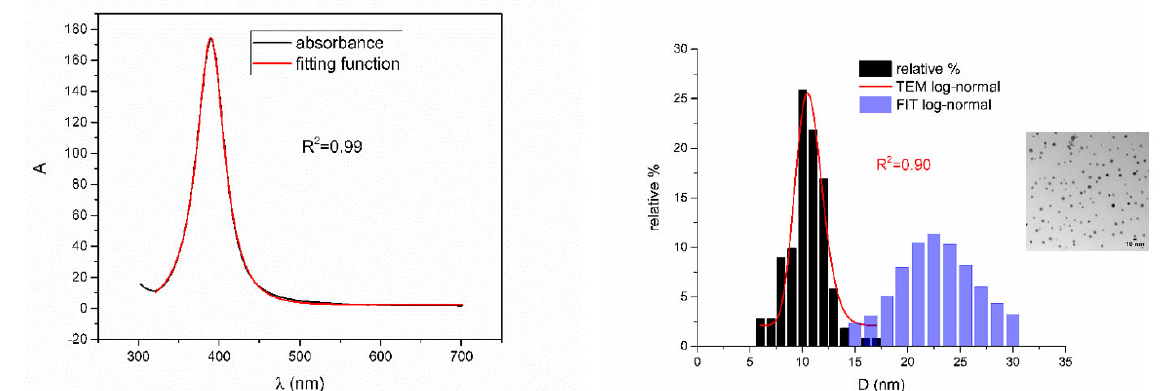
Figure 12. UV ‐ Vis spectrum with fitting function ( left ) for sample BioP_2. Reported and recon ‐